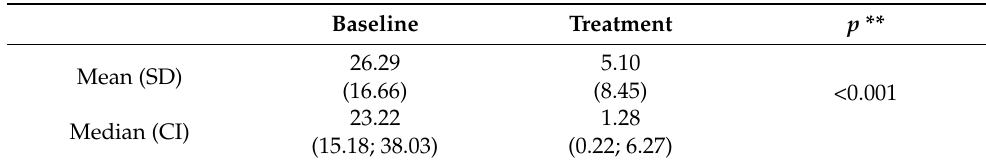
Table 3. Comparison of biofilm percentage on inner surface of the upper denture at the baseline and after treatment (95% CI).